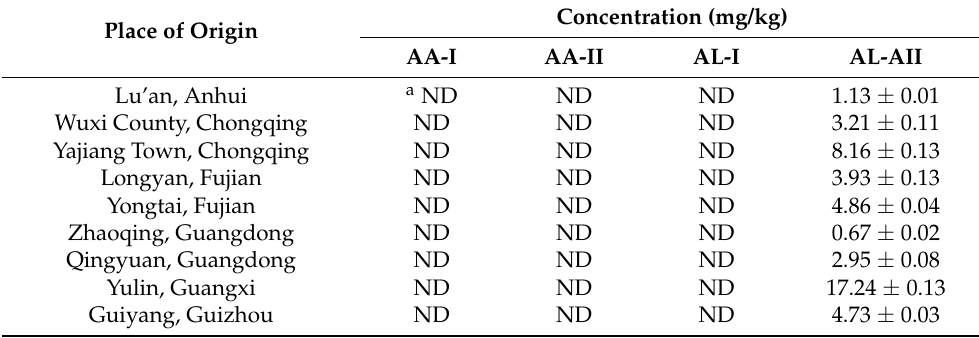
Table 5. Analytical results of aristolochic acids and their analogues in Houttuynia cordata collected from 22 different regions in China ( n =